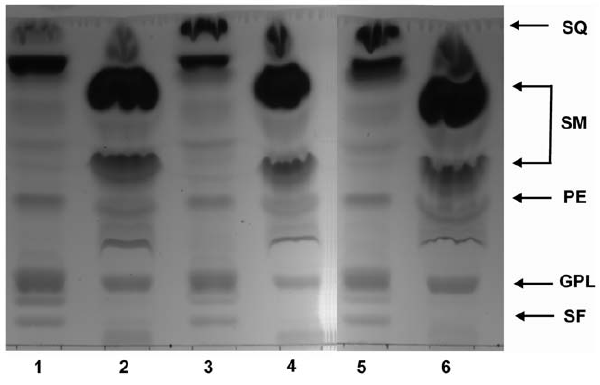
Figure 4. TLC analysis of complex lipids. Effect of simvastatin treatment on glycerophospholipids, apparently not connected with mevalonate pathway. Lanes 1, 3, 5 lipids from cells harbouring the wild- type yeast, or the wild-type or mutated hHMGR gene, respectively. Lanes 2, 4, 6 lipids from cells treated with simvastatin harbouring the wild-type yeast, or the wild-type or mutated hHMGR gene, respectively. Abbreviations: SQ squalene, SM simvastatin metabolites, PE phosphti- dylethanolamine, GPL glycerophospholipids, SF sphingomyeline.